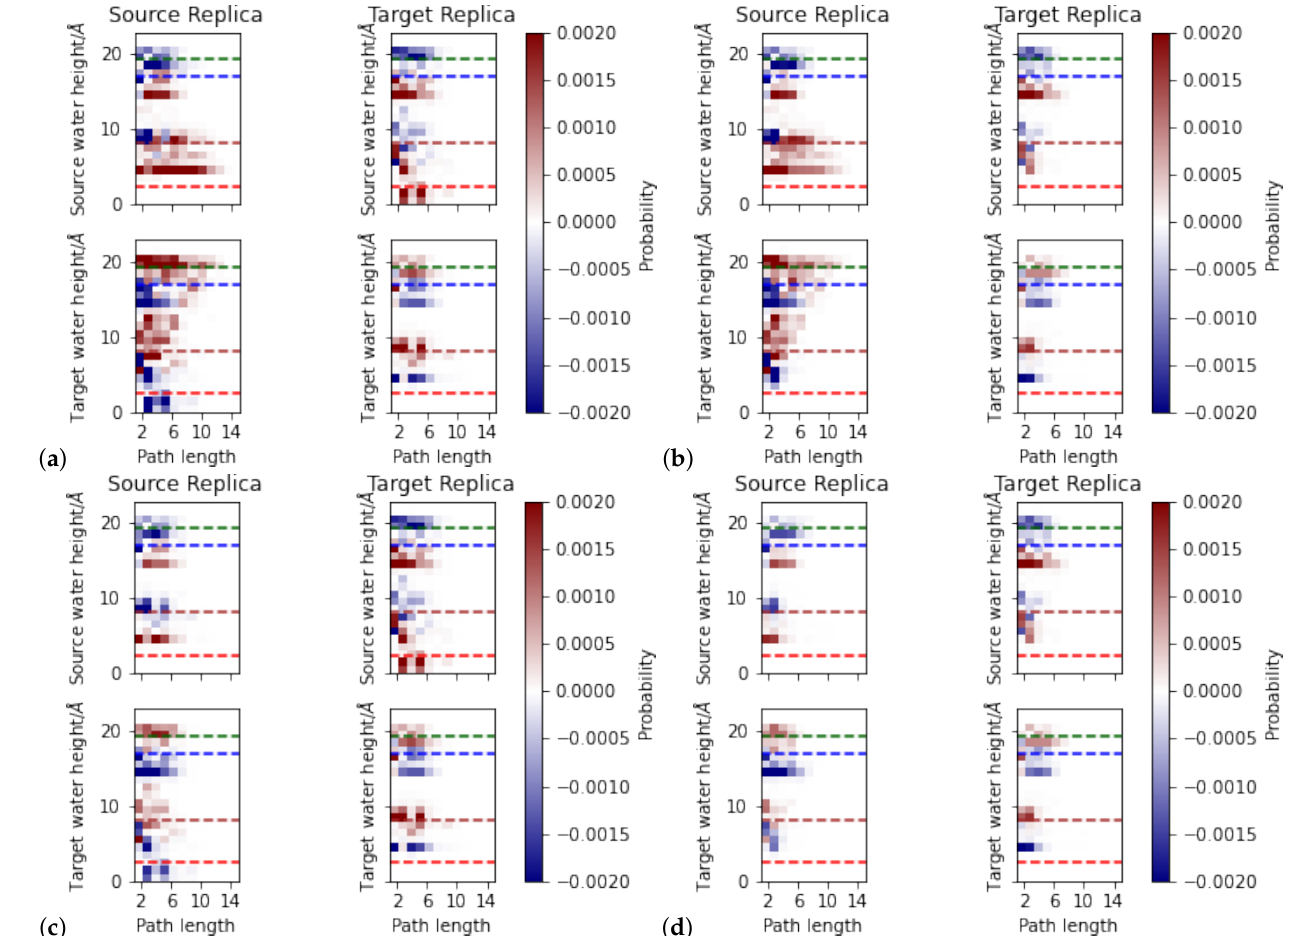
Figure 11. Difference in position-dependent acceptance for proton exchange between “downwards” (direction from Y288 to H96) transitions and “upwards” (direction from H96 to Y288) transitions, as a function of the transition step size as measured by the length of the hydrogen-bonded chain in “up” models. Blue and negative signs represent more “downwards”, and red represents more “upwards” transitions. The probabilities for “upwards” and “downwards” are shown separately in Supplementary Figure S5. Dashed lines indicate the average position of protein residues E101 (red), S365 (brown), K362 (blue), and T359 (green). Criteria for proton transfer acceptance other than energy: ( a ) existence of a hydrogen-bonded connection in the source replica, ( b ) existence of a directed hydrogen-bonded connection in the source replica, ( c ) existence of a directed hydrogen-bonded connection in the source replica, and ( d ) existence of a directed hydrogen-bonded connection in the source and target replica as additional